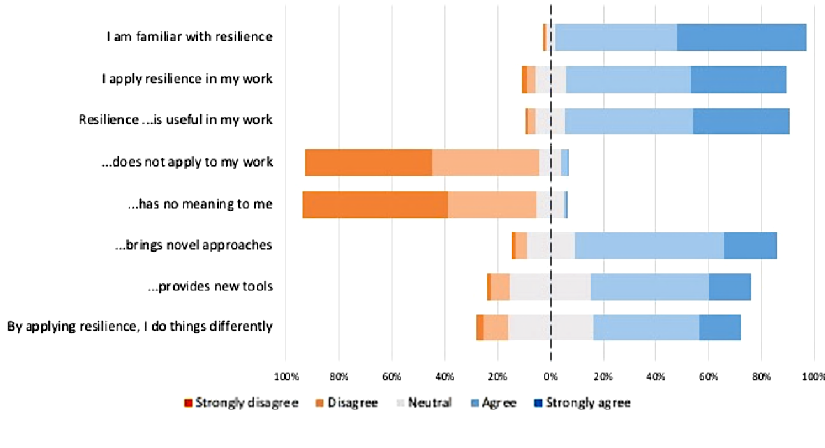
Fig. 1 . Familiarity and novelty of resilience. The Likert-scale questions are listed on the left. This graph shows that most survey participants were familiar with resilience, and used or applied it in their work. Most participants also found resilience to bring novel approaches; however, slightly fewer participants indicated that they did things differently in practice as a result of applying resilience concepts.